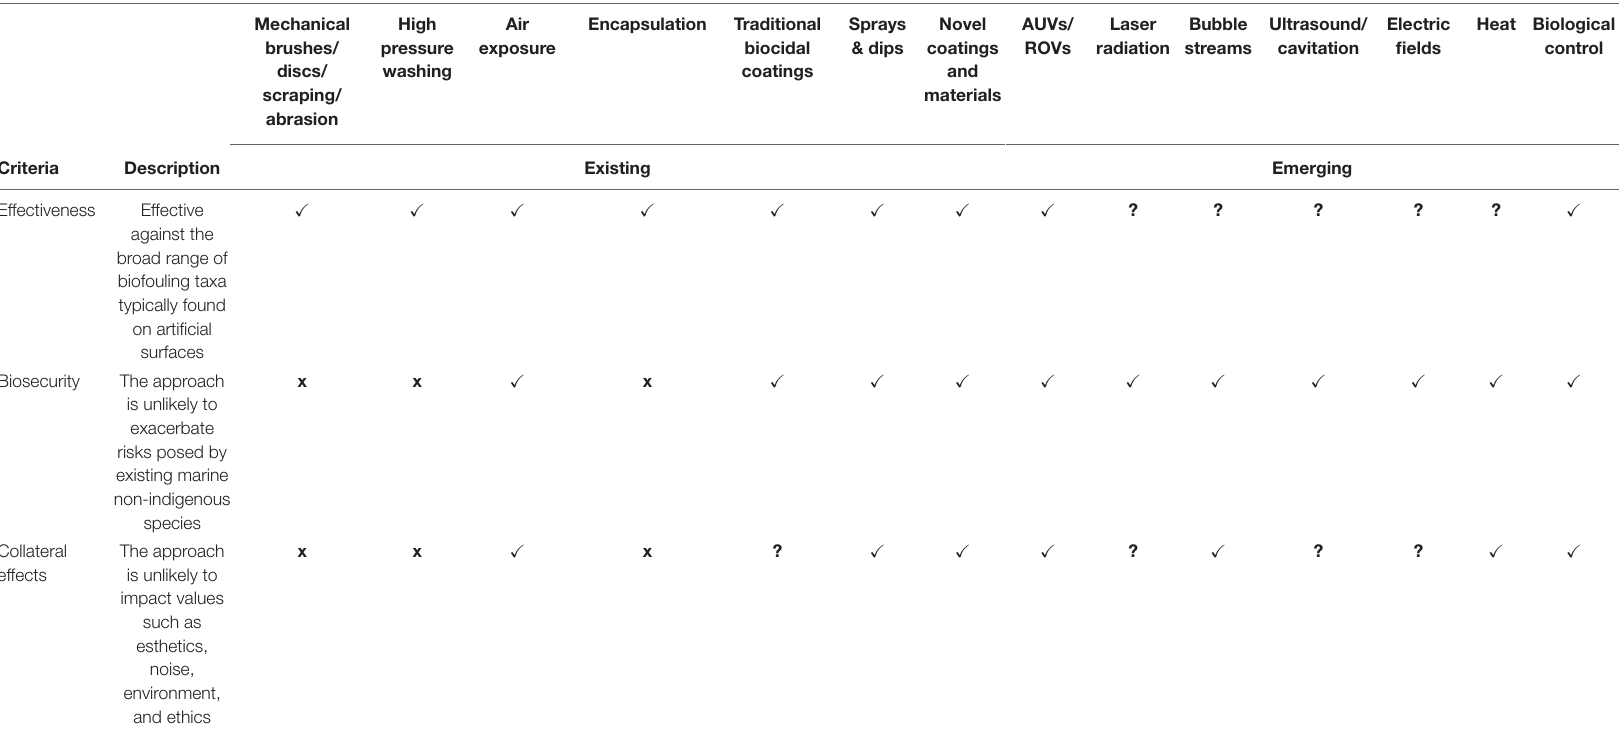
TABLE 3 | Performance evaluation of existing and emerging management methods and approaches to manage static marine infrastructure.